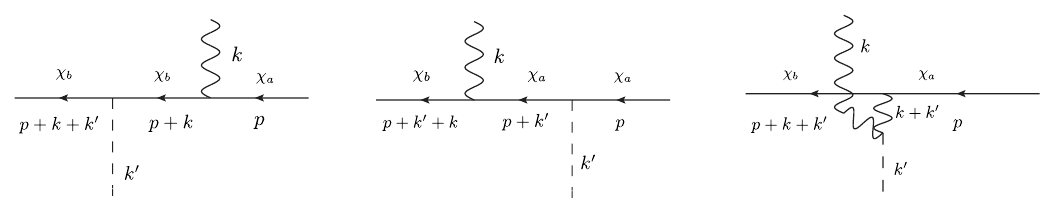
Figure 11 . Dark photon outer leg \skipping" over a dark Higgs